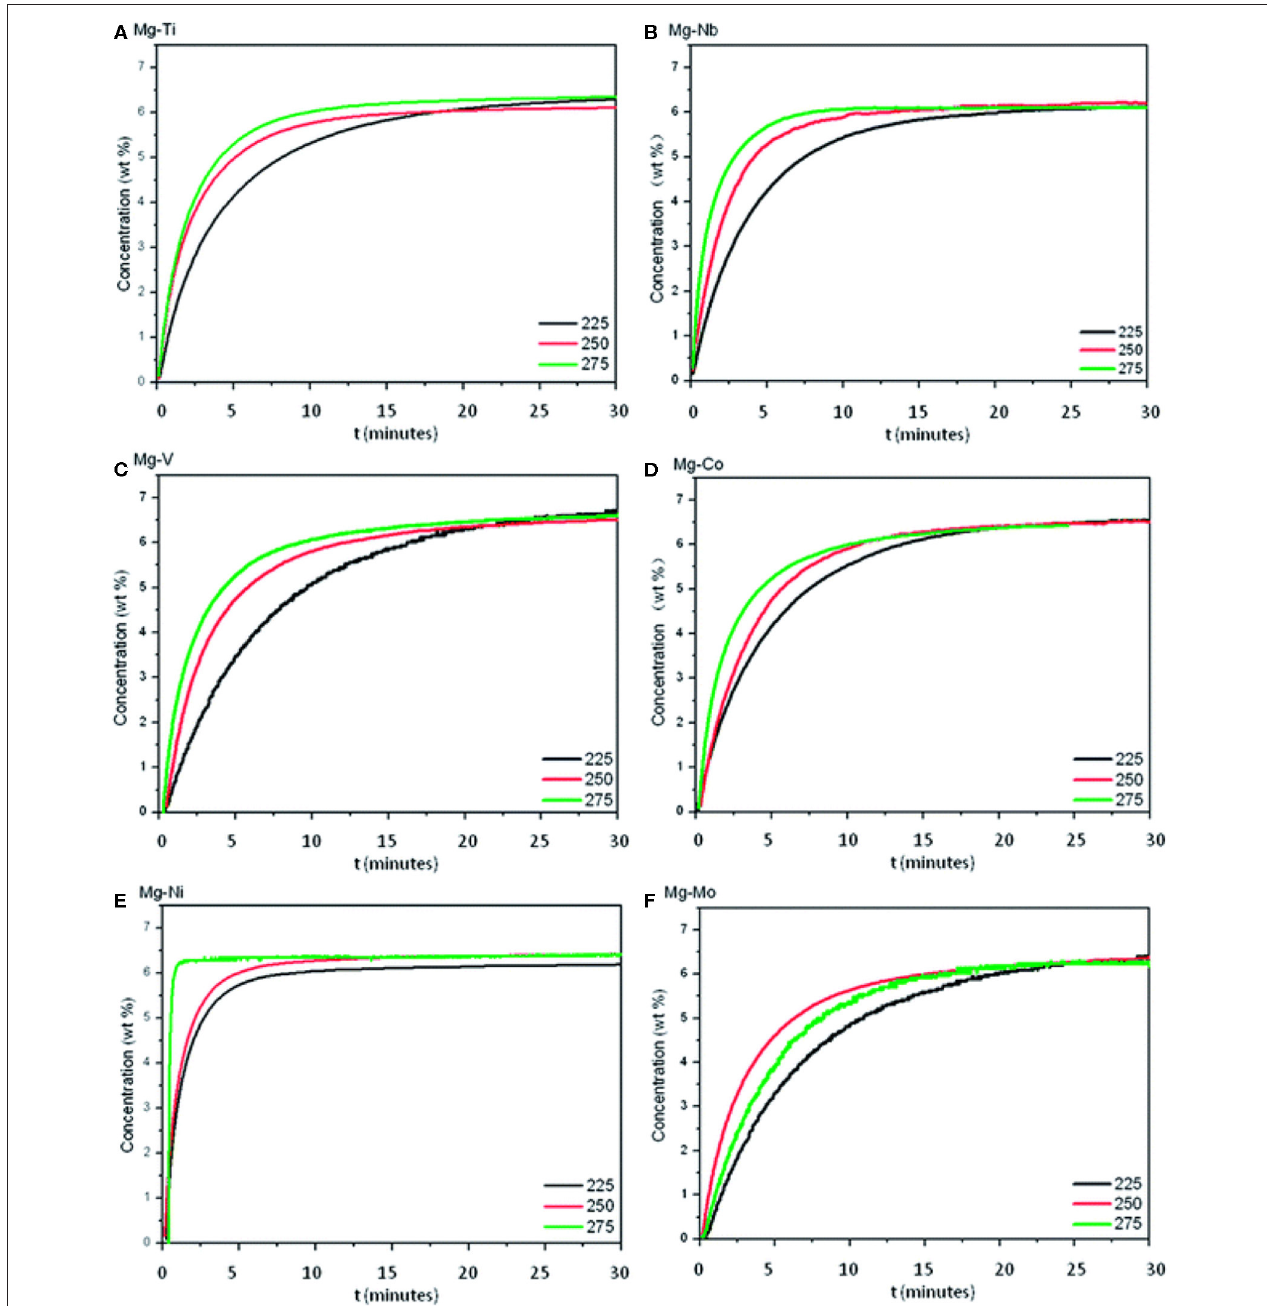
FIGURE 2 | Isothermal dehydrogenation curves of Mg–TM samples at 225, 250, and 275 ◦ C. (A) Mg-Ti; (B) Mg-Nb; (C) Mg-V; (D) Mg-Co; (E) Mg-Ni; (F) Mg-Mo. Reproduced from Cui et al. (2014) with permission from Royal Society of